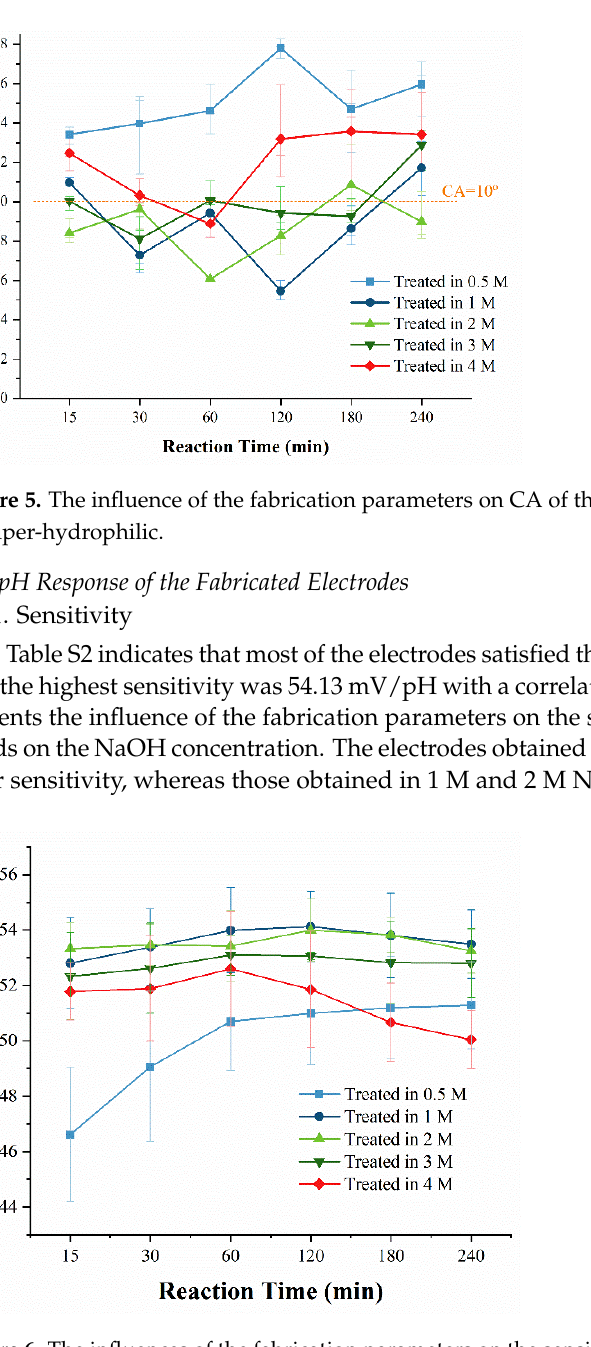
Figure 6. The influences of the fabrication parameters on the sensitivity of the porous TiO 2 elec- trodes.